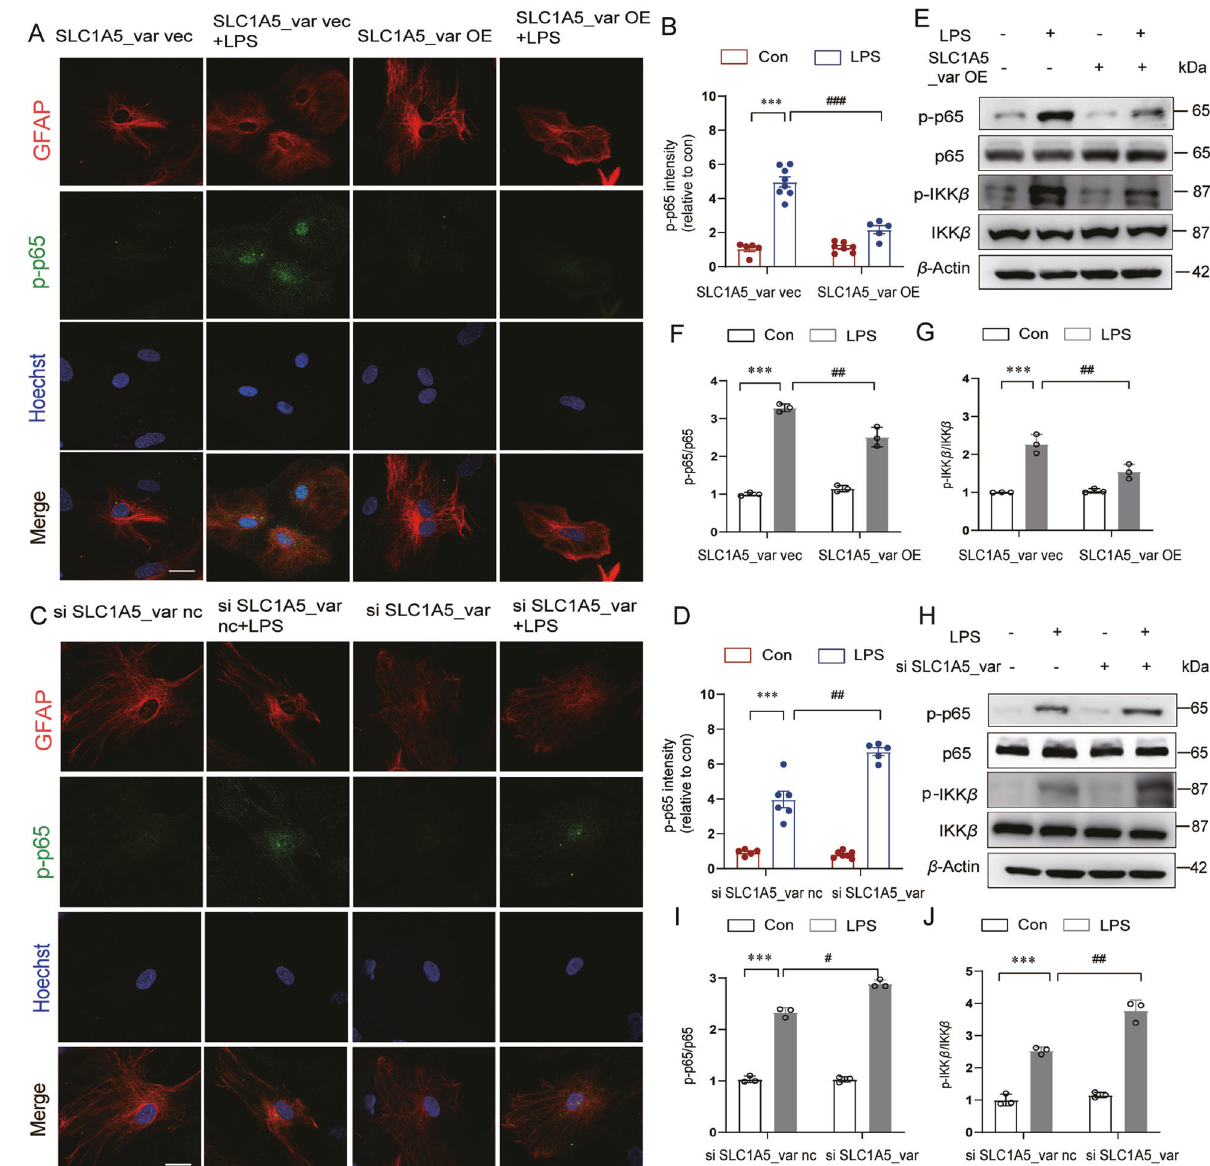
Fig. 4 SLC1A5_var signi fi cantly blocks the nuclear translocation of p-p65 in LPS-stimulated astrocytes. Astrocytes were transfected with SLC1A5_var OE ( A , B ) or SLC1A5_var siRNA ( C , D ) for 48 h and then stimulated with LPS for 6 h. Phosphorylation of nuclear translocation of NF- κ B (p65) was assessed by fl uorescence microscopy ( n = 5 – 8). Scale bar represents 20 μ m. Phosphorylation of IKK β and p65 was determined by western blot analysis ( E , H ) and quanti fi ed by densitometry ( F , G and I , J ). Data are shown as the mean ± S.E.M. *** P < 0.001 vs